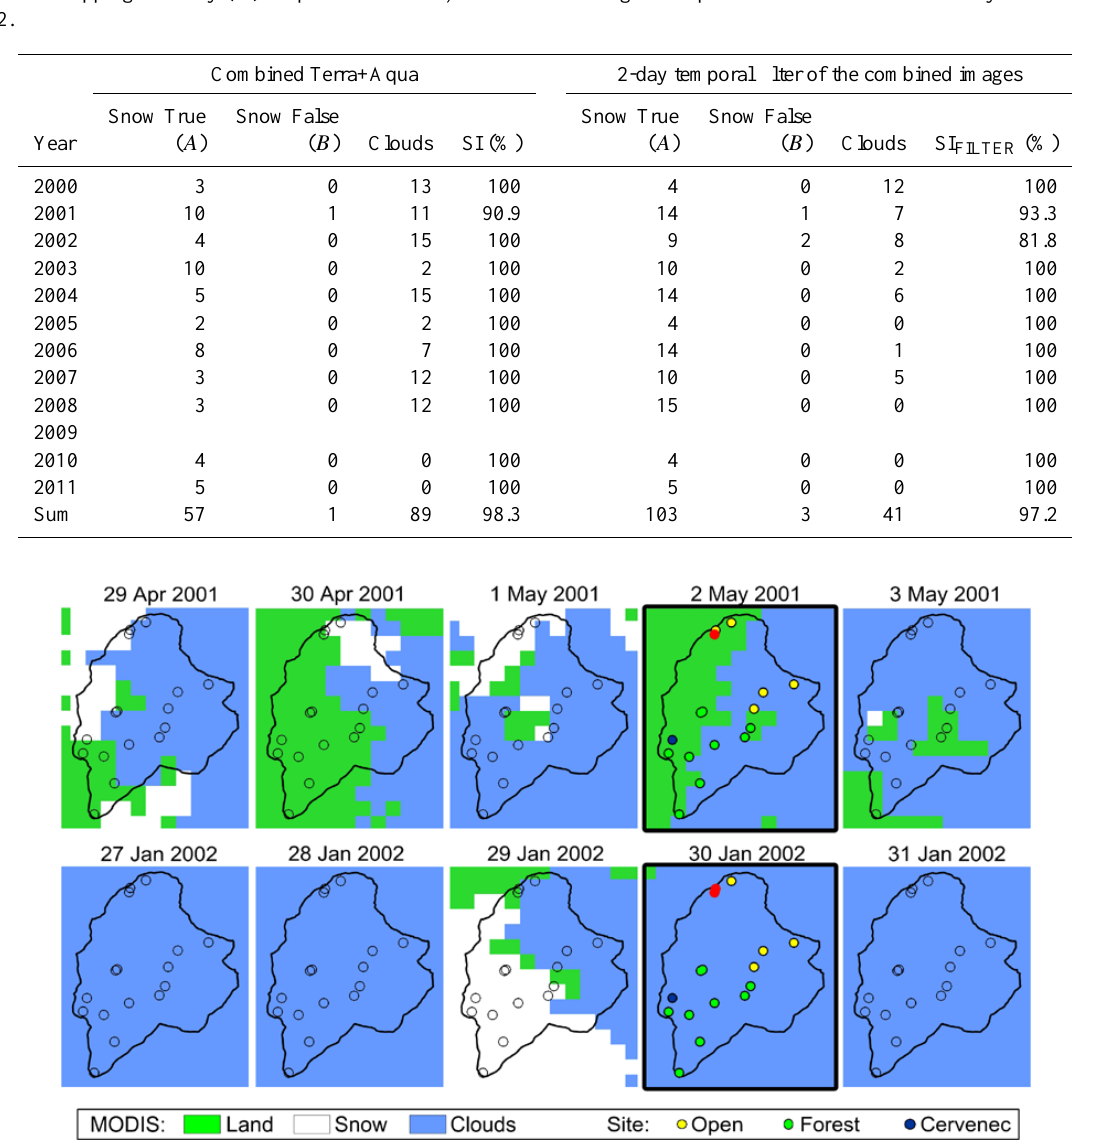
Table 3. Snow mapping accuracy (SI) at open sites. The A , B and Clouds categories represent the number of station days and are defined as in Table 2.